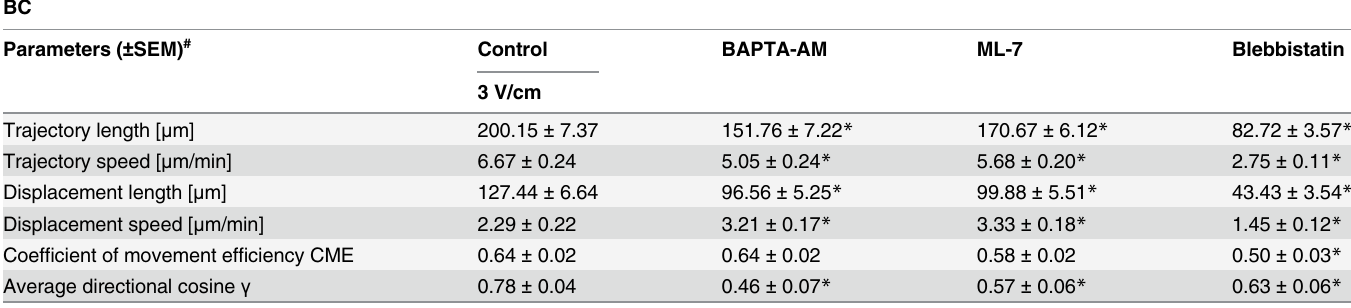
Table 6. Quantitative data showing the effects of BAPTA, blebbistatin and ML-7 on the electrotaxis of BC cells. BC